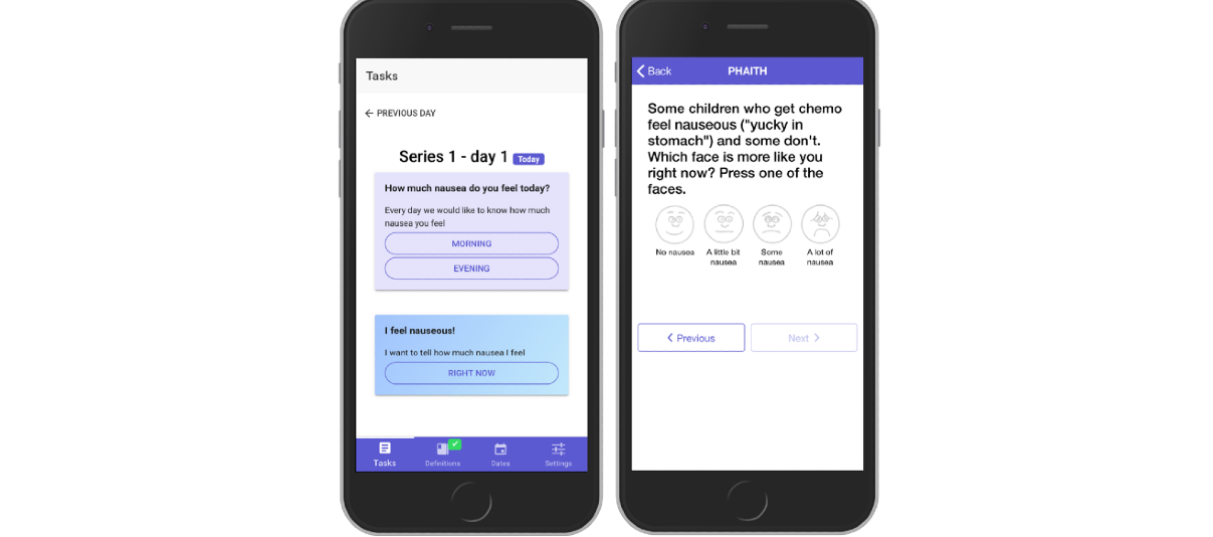
Figure 3. The app with overview of the day’s task (left) and the patient’s expression of nausea severity